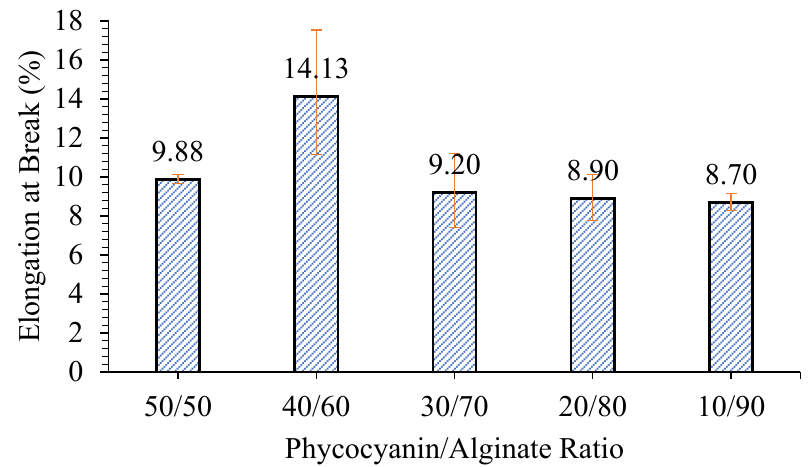
Figure 3. Elongation at break of patches with various phycocyanin/alginate ratios.